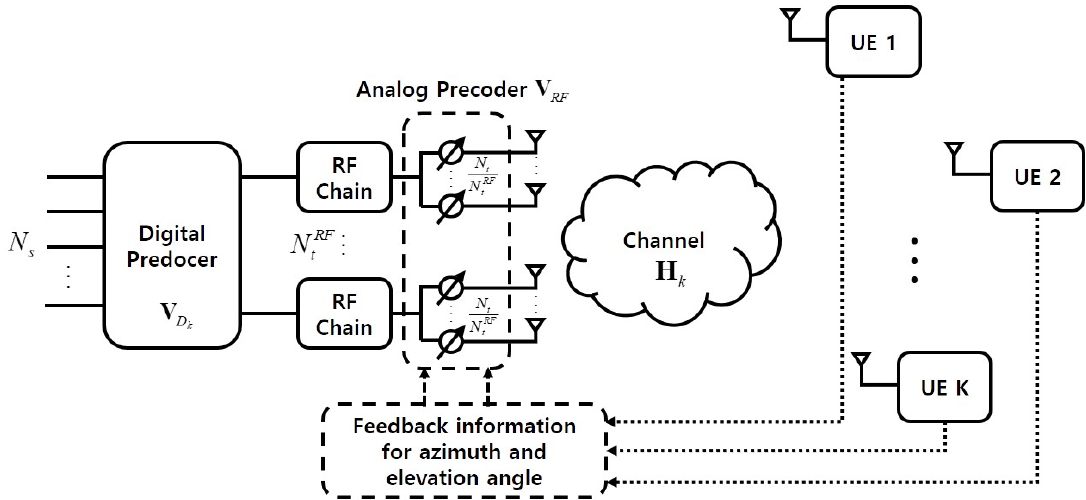
Figure 7. The PCS hybrid beamforming system including the feedback process.